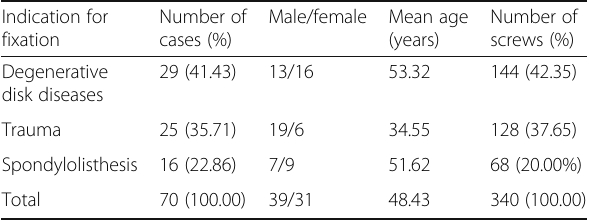
Table 1 Distribution of patients according to their gender, age, number of screws, and indication for surgery Indication for